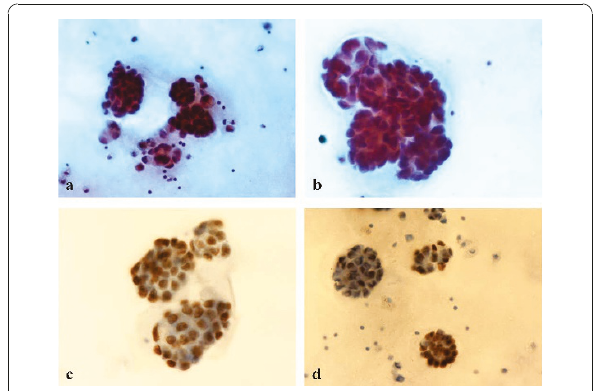
(Papanicolaou stain, ×400). b) Clusters of malignant cells with morphological features of adenocarcinoma (Papanicolaou stain, ×600). c) Immunocytochemical positivity to TTF-1 (×350). d) Immunocytochemical positivity to TTF-1